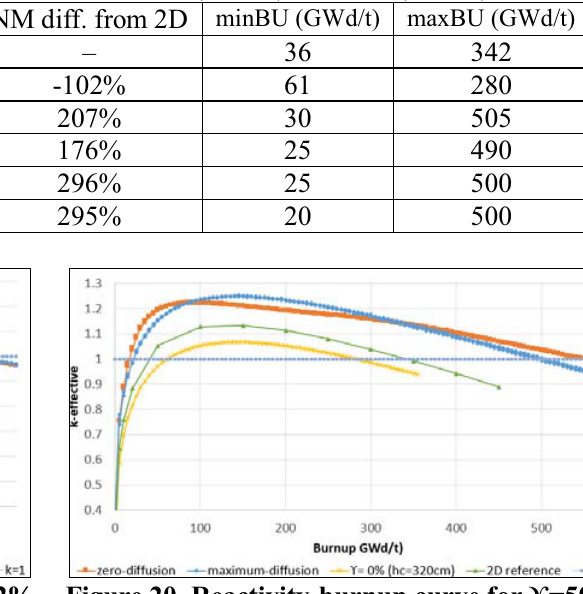
Figure 17. NM with increasing ϒ% ratio. Figure 18. NM % difference. Table III. Results of NM analysis for ϒ ratio : 22% (390cm) and 50% (480cm).